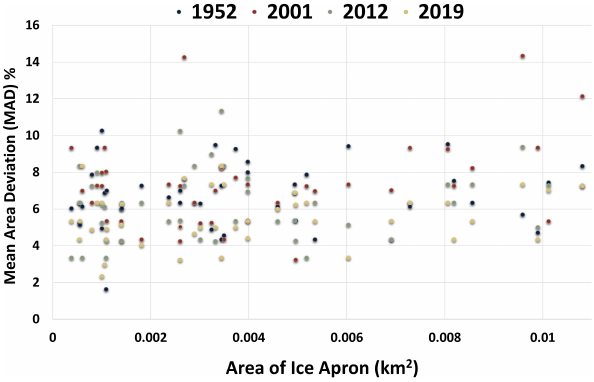
Figure 10. The distribution of MAD values based on multiple digi- tizations of the IA area for all periods.